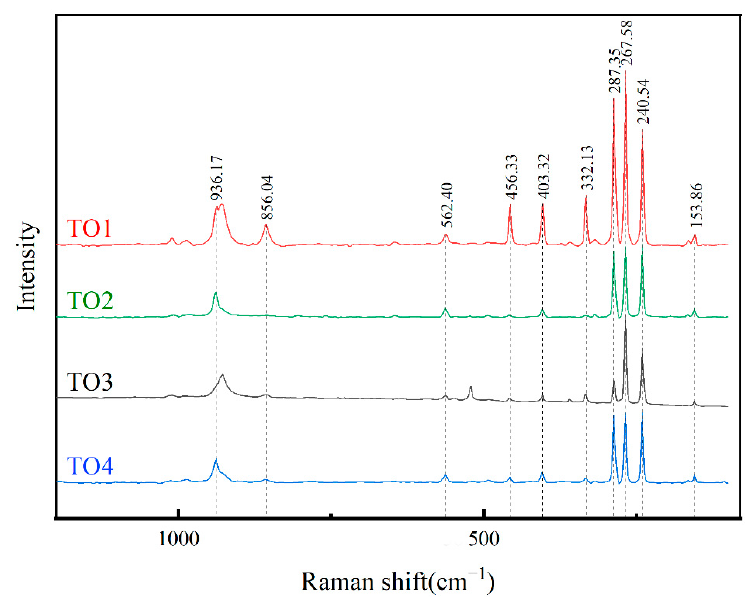
Figure 5. Raman Spectra of yellow topaz samples (100–1200 cm − 1 ).